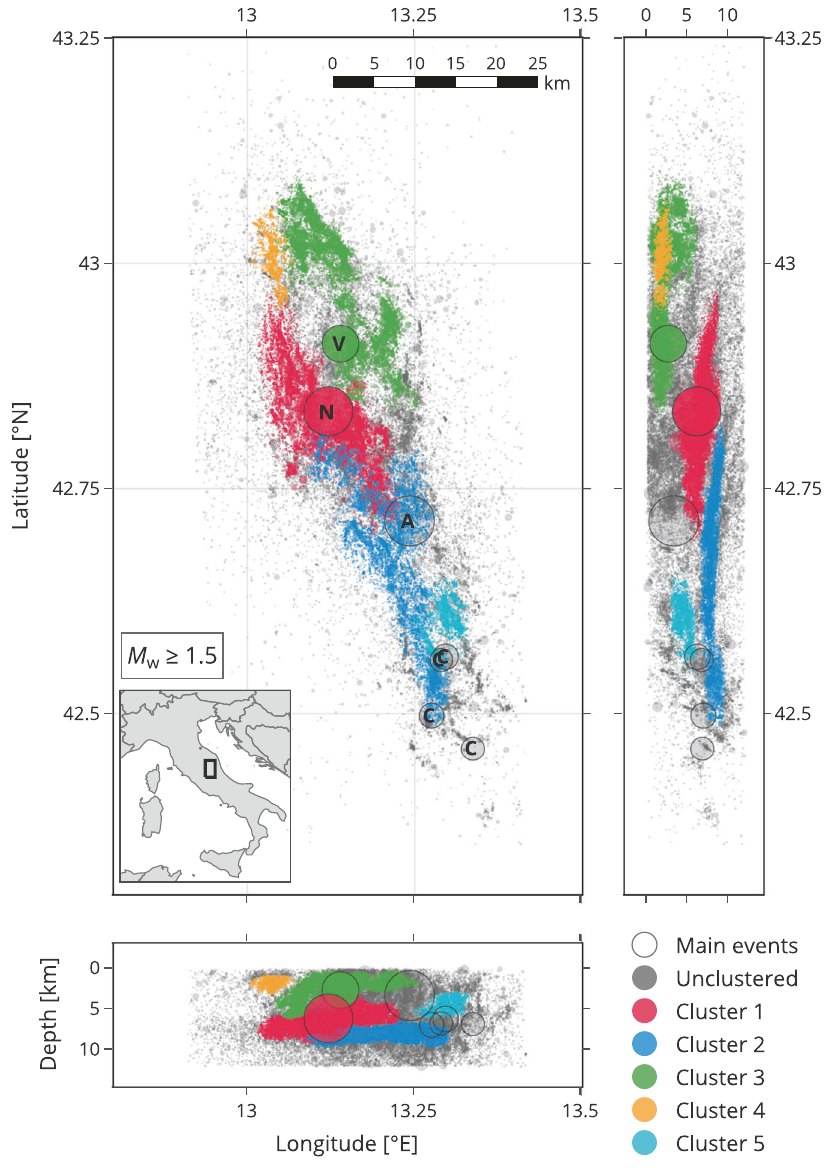
Fig. 1 | Map view and depth sections of the 2016/17 central Italy ( ‘ CI2016 ’ ) seismicity with identi fi ed clusters (see legend). The depth sections are to scale. To better reveal the structure of the individual clusters, the earthquake hypo- centers are plotted ascending by their cluster number on top of ‘ unclustered ’